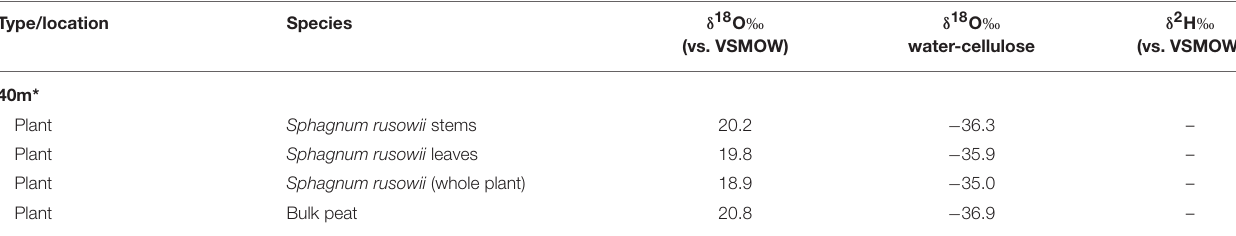
sedges) and at HTF ( n = 38 mosses, n = 7 sedges) was statistically significant at both locations ( P < 0.001 with 7 and 10 degrees of freedom from HTF and GF,